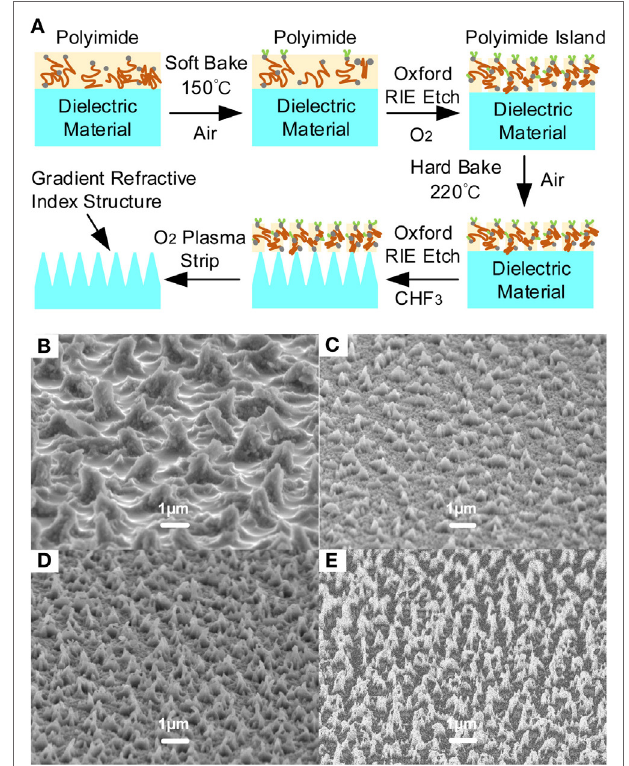
FigUre 4 | (a) Fabrication process flow for the gradient refractive index structure. The SEM pictures of different patterns generated using reactive ion etching (RIE). (B) with a plasma power of 100 W and 100 sccm O 2 , (c) with a plasma power of 100 W and 50 sccm O 2 , (D) with a plasma power of 50 W and 50 sccm O 2 , and (e) with a plasma power of 50 W and 100 sccm O 2 .